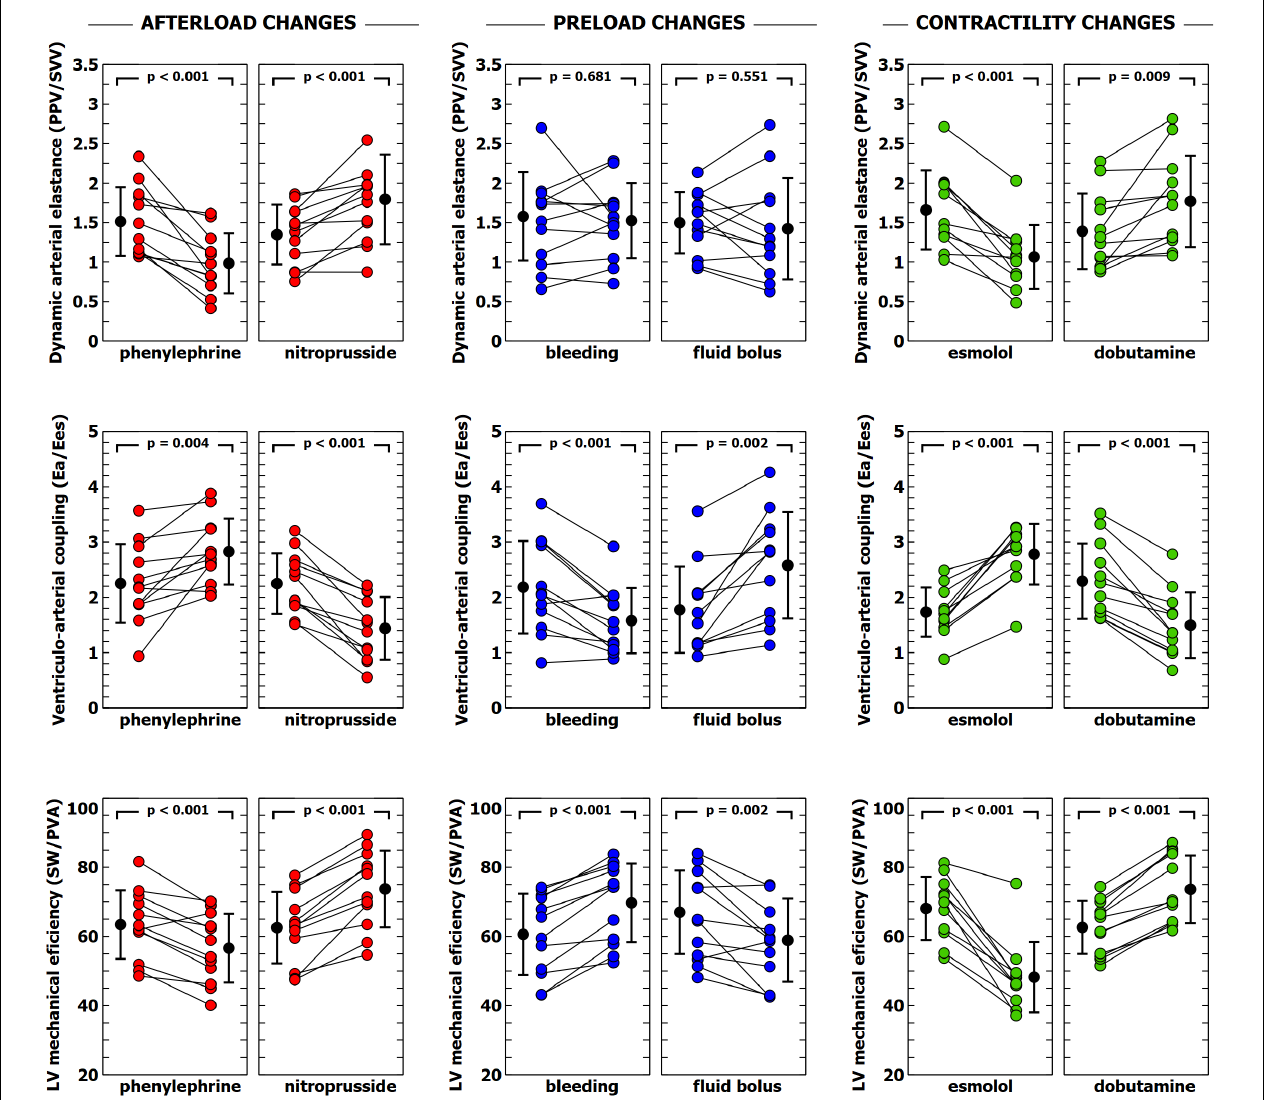
FIGURE 2 | Evolution of dynamic arterial elastance, ventricular-arterial coupling and left ventricular efficiency during different experimental interventions. Individual values of dynamic arterial elastance (Ea dyn ), ventricular-arterial coupling (Ea/Ees) and left ventricular mechanical efficiency during each experimental stage. Black points with bars represent the mean value and the standard deviation. Colored points represent individual changes for each